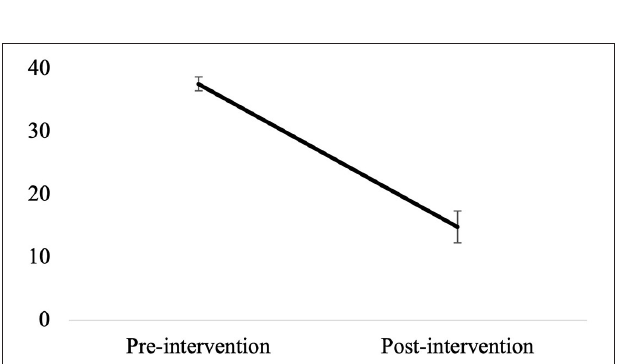
FIGURE 4 | Evolution of psychological distress between the beginning of the program and post-intervention assessment at the end of pregnancy. Error bars represent the standard error for the